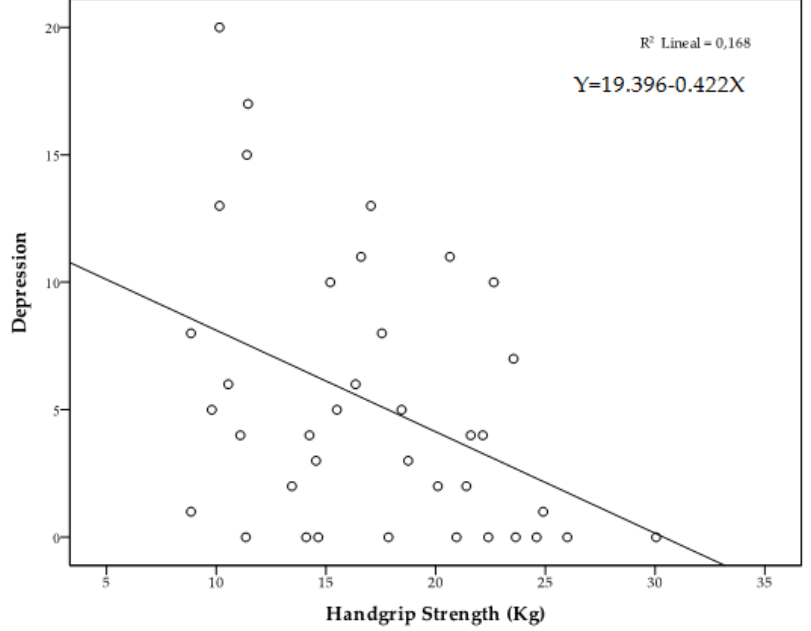
Figure 4. Scatter chart of HGS in relation to depression/sadness.